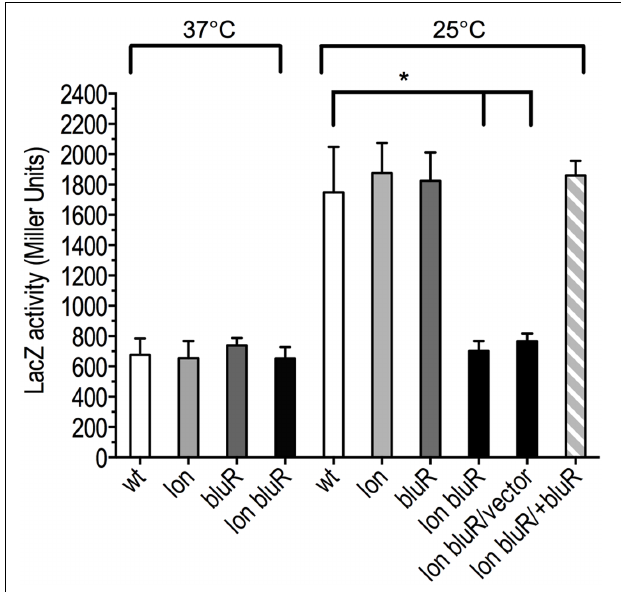
FIGURE 3 | lon and bluR mutations lead to decreased ompF transcription at 25 ◦ C. The β -galactosidase activity (Miller units) of a single chromosomal copy of P ompF-lacZ was measured for cells grown to exponential phase (optical density at 600 nm ∼ 0.6) in LB medium at 25 and 37 ◦ C. Wild type, VDL25113; lon , VDL0419; bluR , VDL101; lon bluR , VDL102; vector, pMPM; +bluR, pDVMbluR. Numbers represent the means and standard deviations from at least three independent experiments. Statistically significant differences for a mutant compared to wild type are shown as asterisk ( ∗ P <